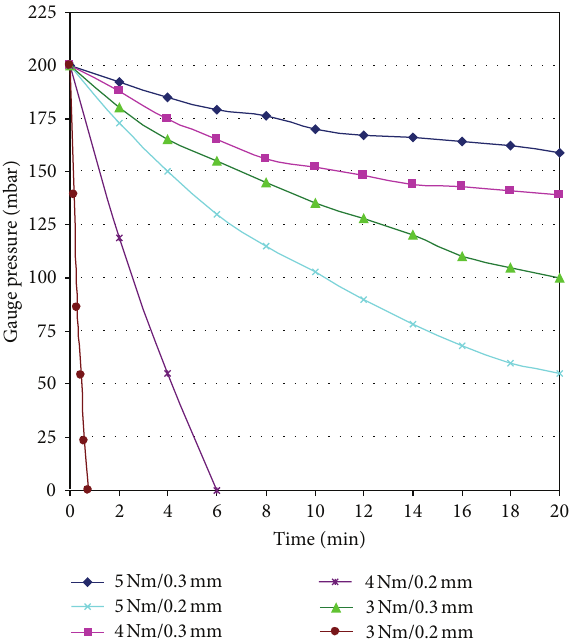
Figure 11: Variation in the gauge pressure of air for different fuel cell assembly with PTFE gasket.